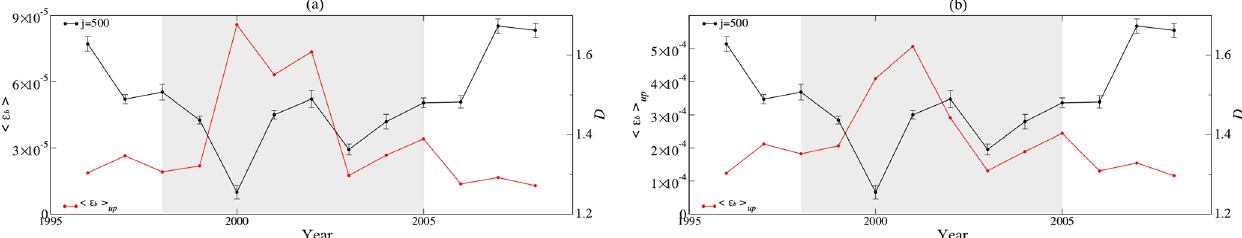
Figure 9. Box-counting dimension of magnetic forcing term for j = 500 with respective activity of (cid:15) b (t) (red lines): (cid:104) (cid:15) b (t) (cid:105) (a) and (cid:104) (cid:15) (cid:105) up (b) , with n = 5. The grey region corresponds to the maximum period of the solar cycle, as described in the text. b